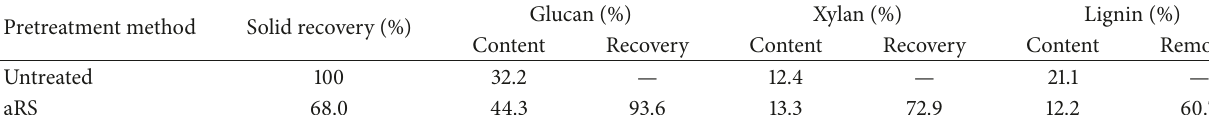
Table 1: Recovery of total solids, glucan, xylan, and residual lignin contents in untreated and pretreated RS.